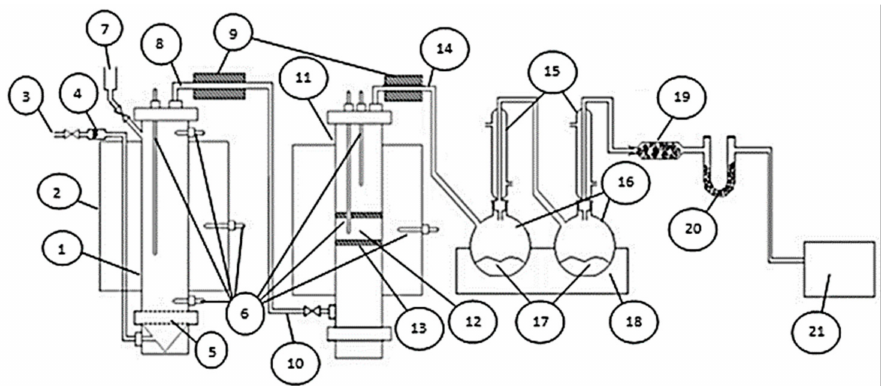
Figure 2. A schematic diagram of the secondary catalytic gasification setup: (1) Primary gasifier;